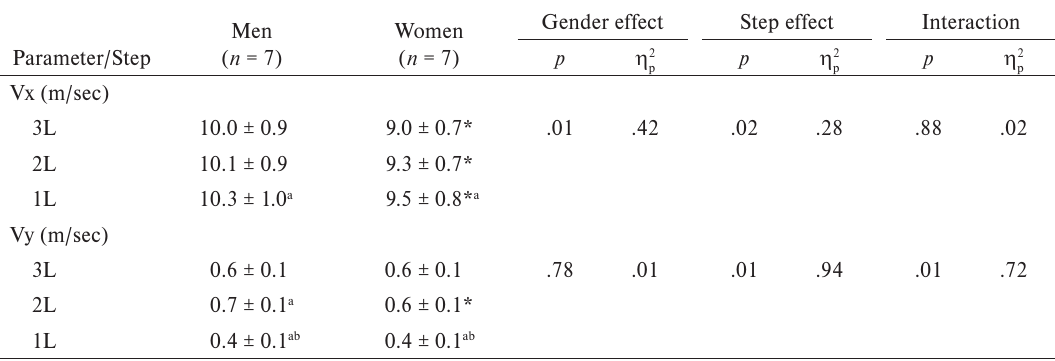
Results of the horizontal and vertical BCM take-off velocities (mean ± SD) and of the statistical testing between the examined men and women long jumpers at the final three steps of the approach